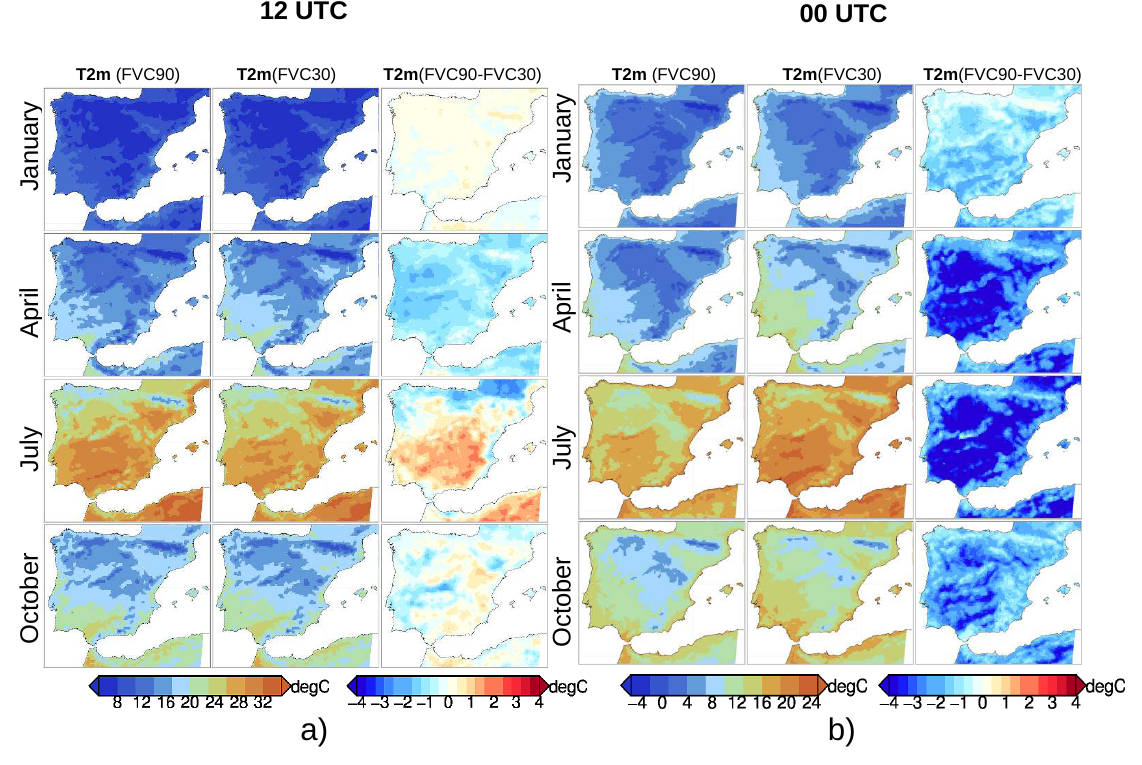
Figure 3. T2m ( ◦ C) for experiments FVC90 and FVC30 and their differences at 12 UTC ( a ) and at 00 UTC ( b ) for January, April, July and